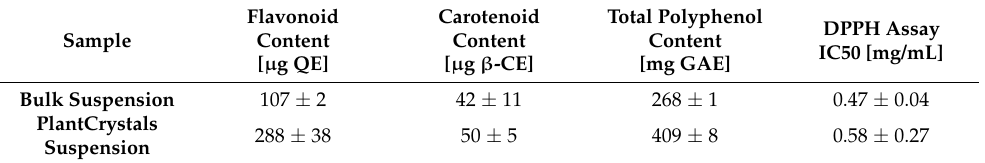
Table 2. Results of content analysis and Antioxidant Capacity (AOC)